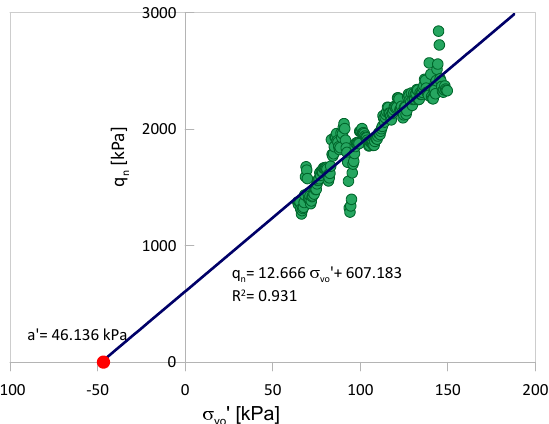
Figure 2. Determination of a ’ based on the trend of q n against σ ’ vo based on results from a single CPT profile.